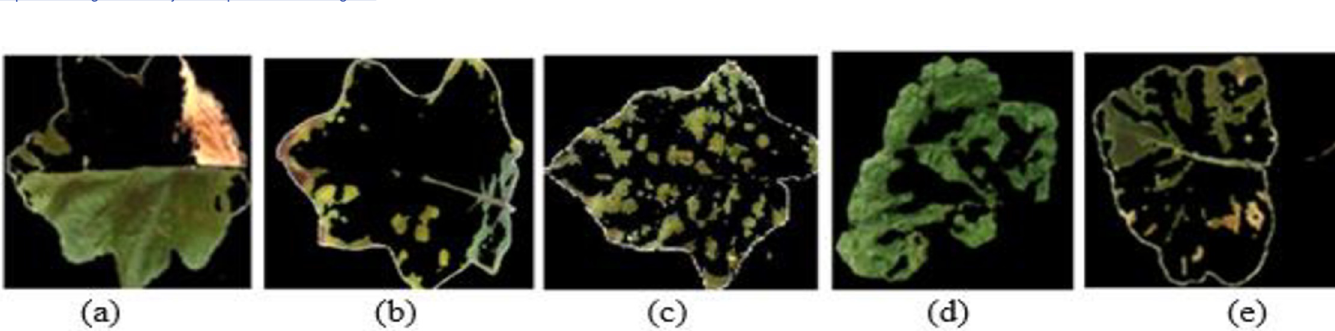
Fig 7. Expectation Maximization segmentation for brinjal leaf (a) Pseudomonas solanacearum (b) Cercospora solani (c) Alternaria melongenea (d) Pythium aphanidermatum (e) Tobacco Mosaic Virus .